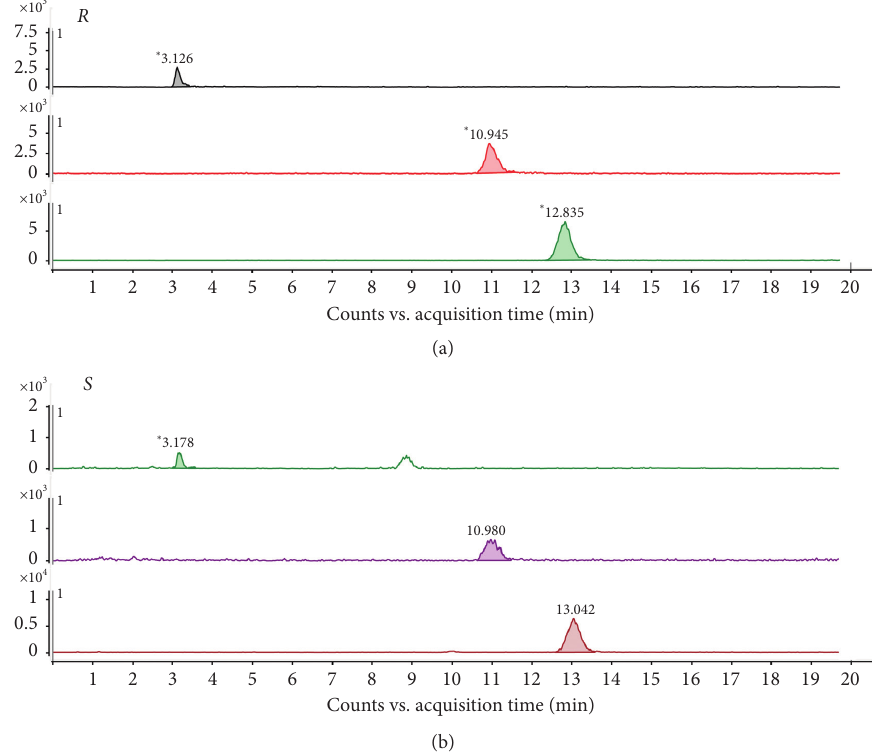
Figure 3: MRM chromatograms of reference standards and LDXGW sample ( R : reference standards; S : sample